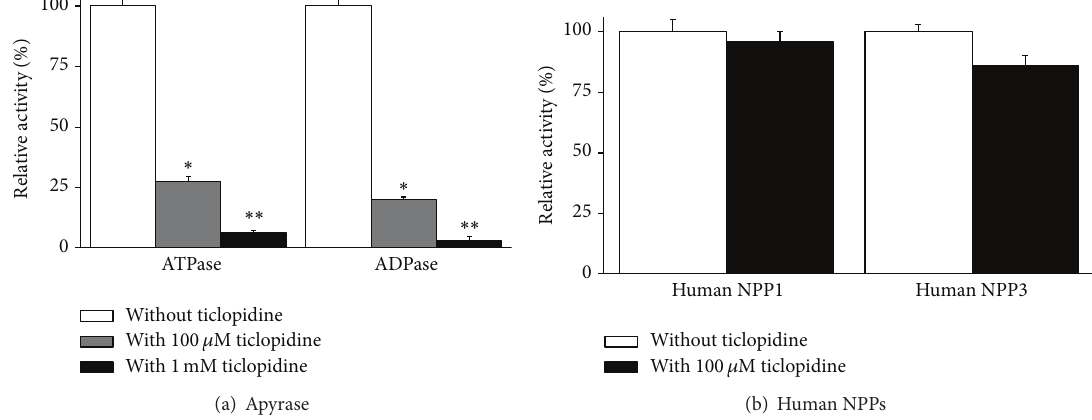
Figure 4: Influence of ticlopidine (100 𝜇 M or 1mM) on the ATPase and ADPase activity of apyrase (a) and (100 𝜇 M) on human NPP1 and human NPP3 (b). The activity of apyrase without ticlopidine was 159±7 and 87±4𝜇 moles Pi/min ⋅ mg protein for ATP and ADP, respectively. Data are presented as the mean ± SD of 3 experiments carried out in triplicate. The 100% activities without ticlopidine with pNP-TMP as the substrate were 71 ± 3 and 17 ± 1 nmol p -nitrophenol/min ⋅ mg protein for NPP1 and NPP3, respectively. ∗ 𝑃 = 0.0045 ; ∗∗ 𝑃 = 0.0002